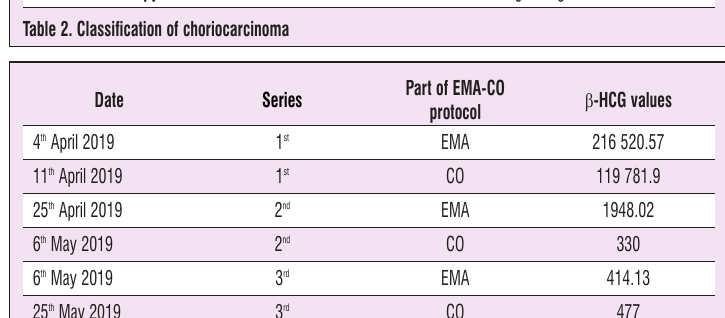
Table 2. Classification of choriocarcinoma